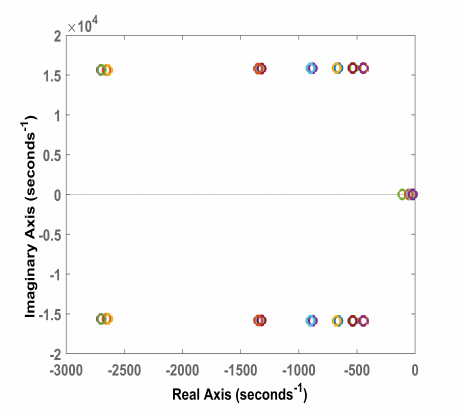
Figure 5. Transfer function Gi L 1 d _ u ( s ) with minimum phase condition for boost mode: ( a ) Bode plot. ( b ) Pole-zero map.